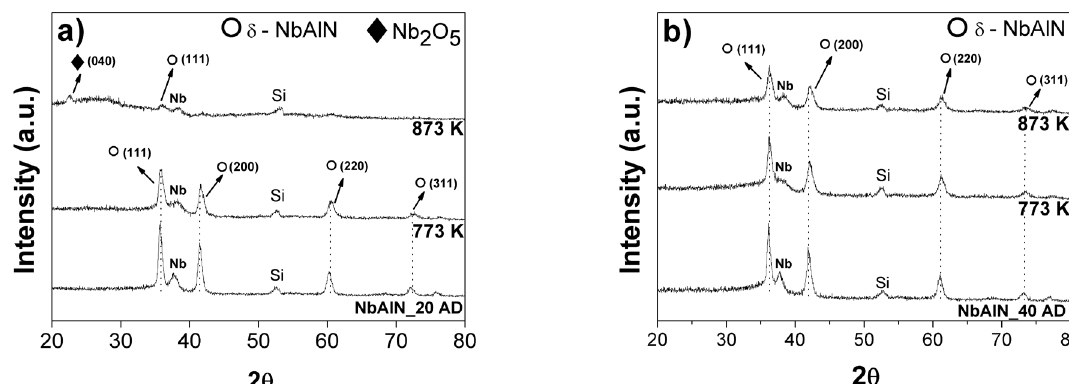
Figure 6. GAXRD patterns for (a) NbAlN_20 and (b) NbAlN_40 samples as deposited and after oxidation tests at 773 and 873 K.